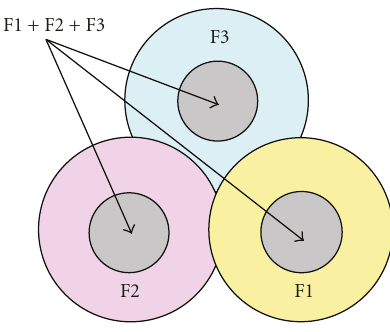
Figure 3: Fractional frequency reuse.